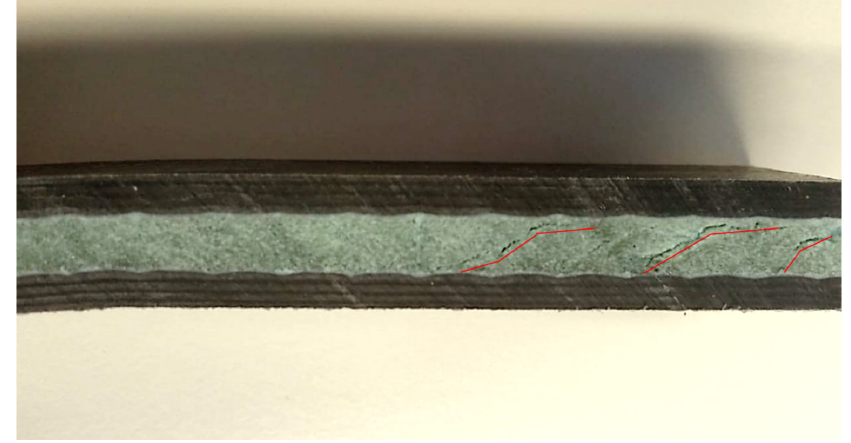
Figure 6. Failure of sample 1 with several clefts.